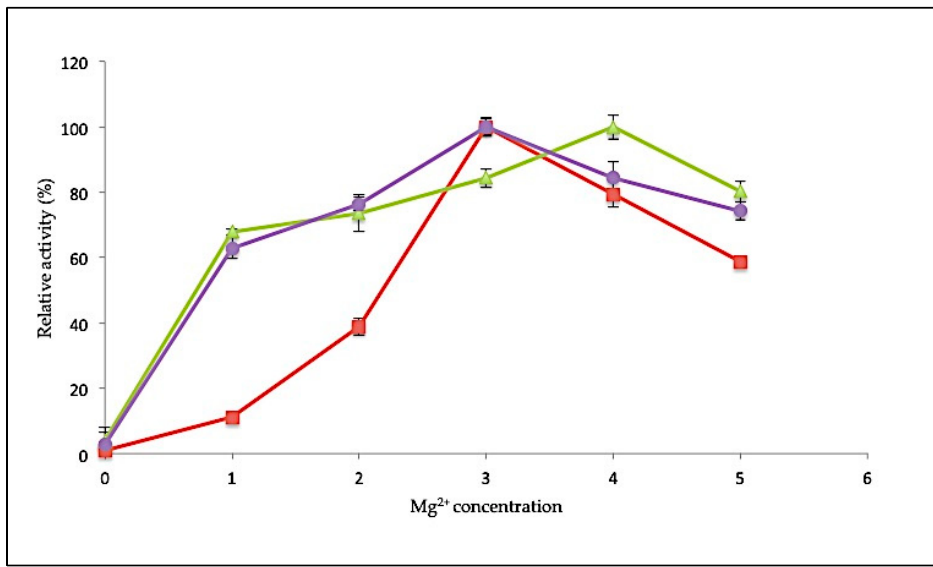
Figure 6. Effect of magnesium ion concentration toward SK72 DNA polymerase I activity and its variants. Note: SK72 (red), SK72-Exo (green), and SK72-Exo2 (purple). The assay took place at optimum temperature for each variant and incubation for 30 min. The control consists of an absence of metal ions (0 mM) relative to the maximal activity for each experiment. Error bars represent standard deviation ( n = 3). Absence of the bar indicates that the error is smaller than the symbols.